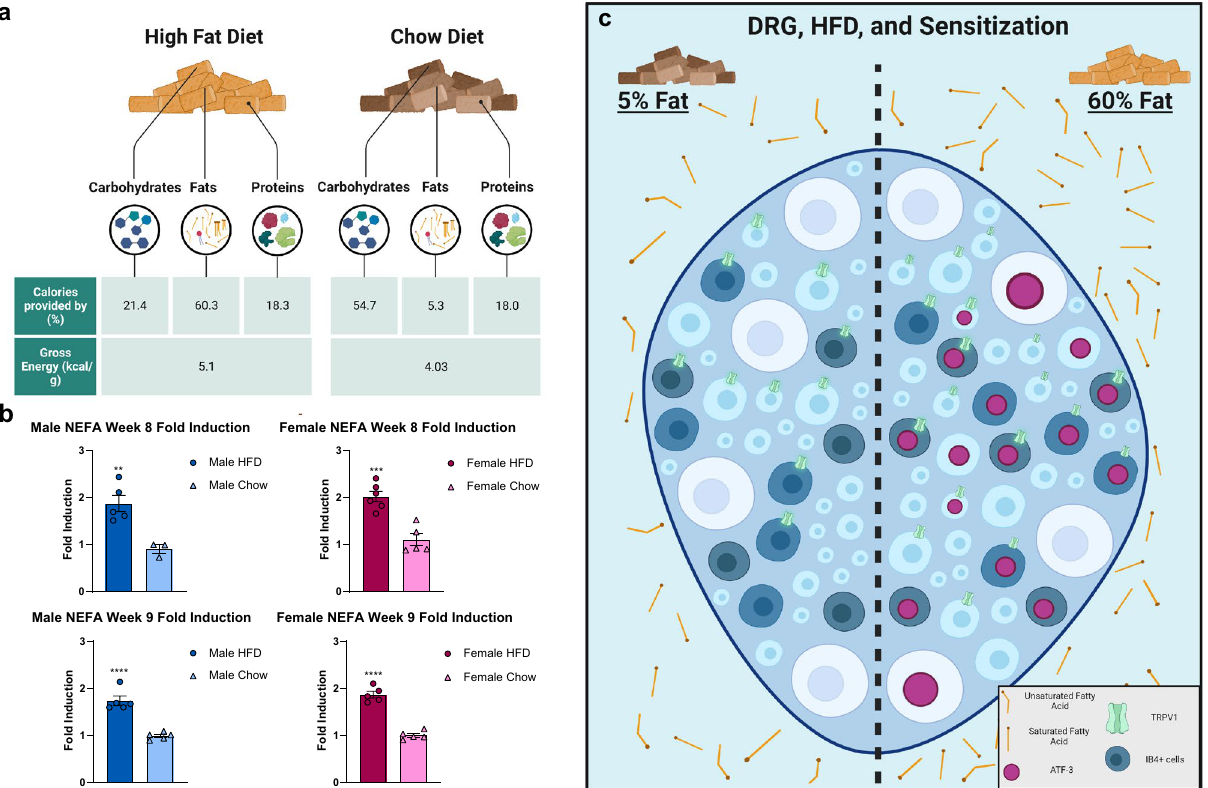
Figure 6. A short-term HFD regime led to an increase in saturated fatty acids which may precipitate the development of diet sensitization. ( a ) HFD males and ( b ) females had significantly higher levels of free fatty acids in their serum in comparison to their chow counterparts on week 8 and 9. *p < 0.05; **p < 0.01; ***p < 0.001; ****p < 0.0001 (two-way ANOVA with Sidak’s post hoc comparison). ( c ) An 8-week HFD regime was shown to be sufficient in sensitizing mice to the subthreshold dose of PGE 2 irrespective of sex. A direct consequence of a short-term HFD regime led to an increase in percentage of capsaicin-response neurons and ATF3 upregulation in DRG neurons, especially in IB4+ nociceptors. Mice on the short-term HFD regime had an observed increase in serum FFA levels from the short-term HFD regime, which primarily consists of saturated fatty